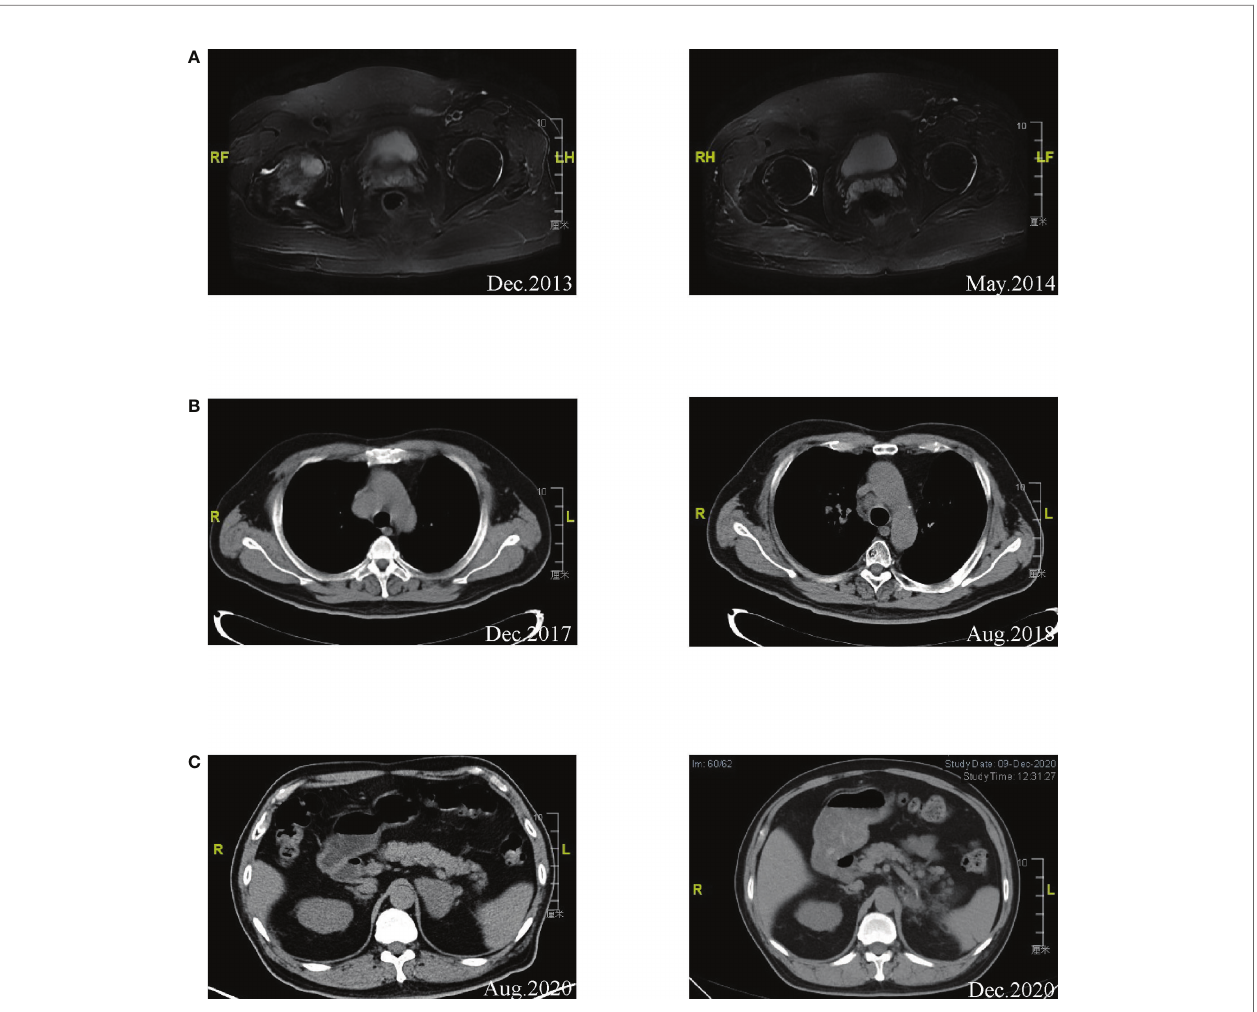
FIGURE 1 | (A) Left: MRI of right femoral head indicating metastasis diagnosis. Right: A partial response was achieved after radiotherapy and ge fi tinib treatment. (B) Left: Disease progression was found in mediastinal lymph nodes by CT. Right: A partial response was achieved after continued ge fi tinib treatment and radiotherapy. (C) Left: Metastasis was detected in the left adrenal gland. Right: CT image of the patient after left adrenalectomy was